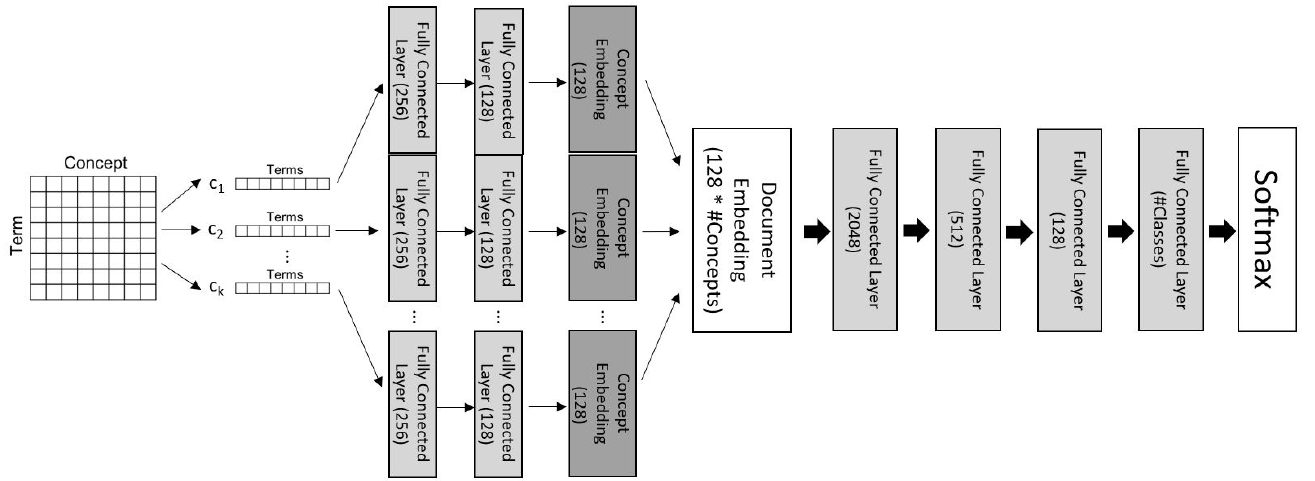
Figure 7. TSM-based deep neural network I: TSM-DNN.